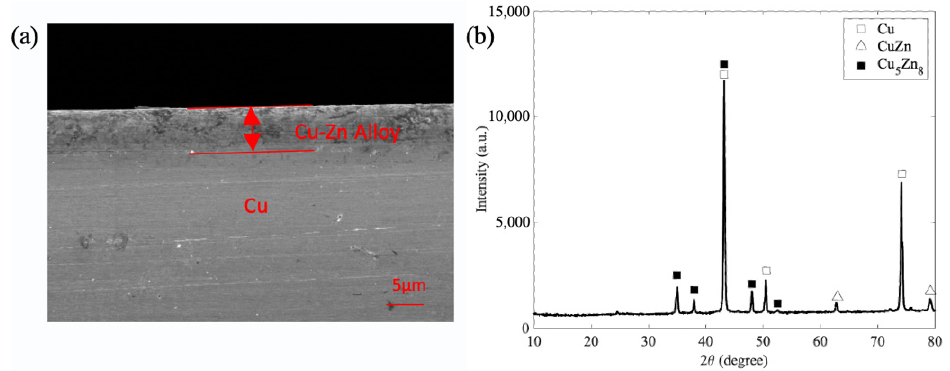
Figure 2. Characterization of the copper surface after dealloying for 30 min, ( a ) SEM image and ( b ) XRD pattern.